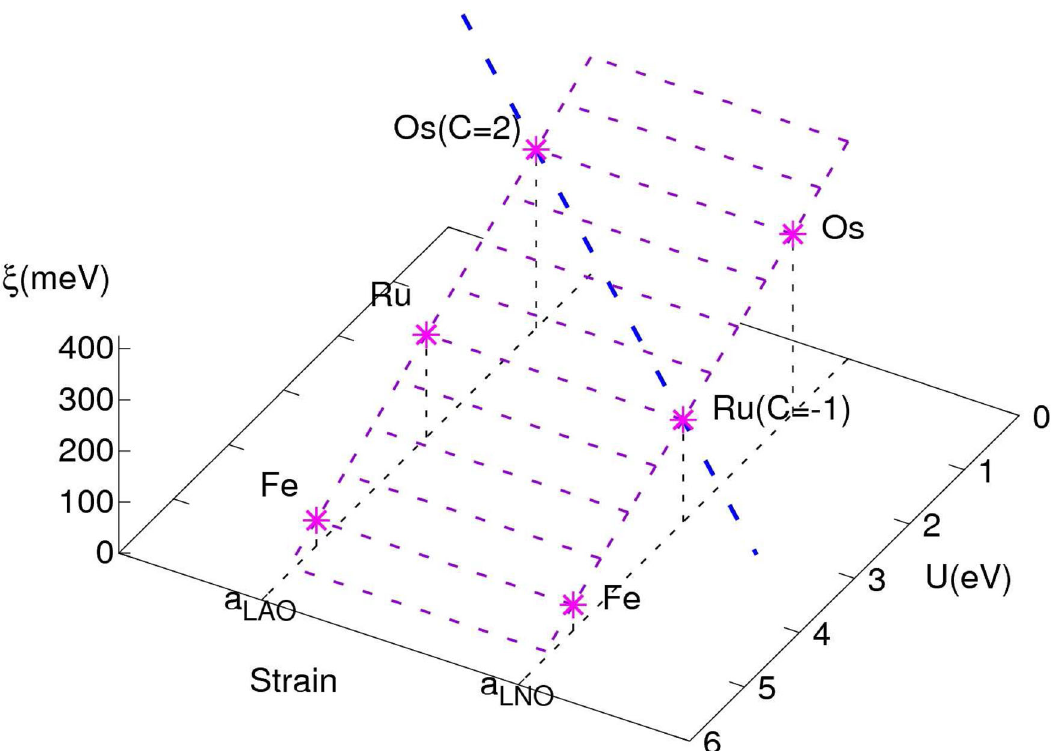
Fig. 5 Schematic diagram in the substrate strain — repulsion U — spin-orbit coupling strength ξ space of the region explored in this work. The area, linear in U , is provided for perspective. The long-dashed diagonal line connects the two Chern phases, as discussed in the